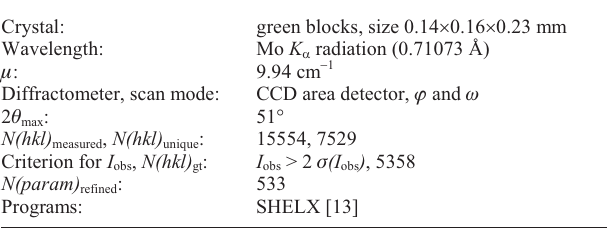
Table 1. Data collection and handling.